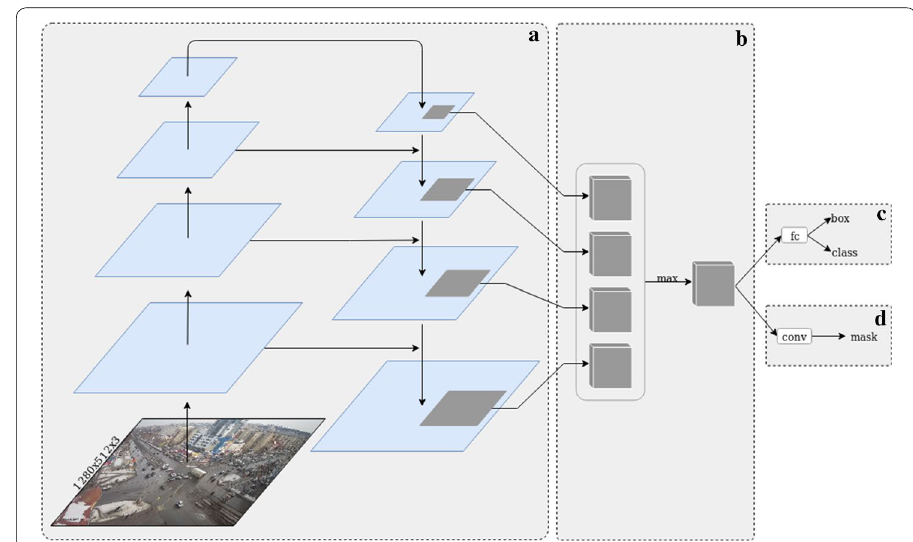
Fig. 2 Conceptual illustration of our detection network: a backbone with feature pyramid network [17]; b adaptive feature pooling [20]; c box branch; d mask branch. Note, that RPN and channel dimension of the feature maps are omitted for